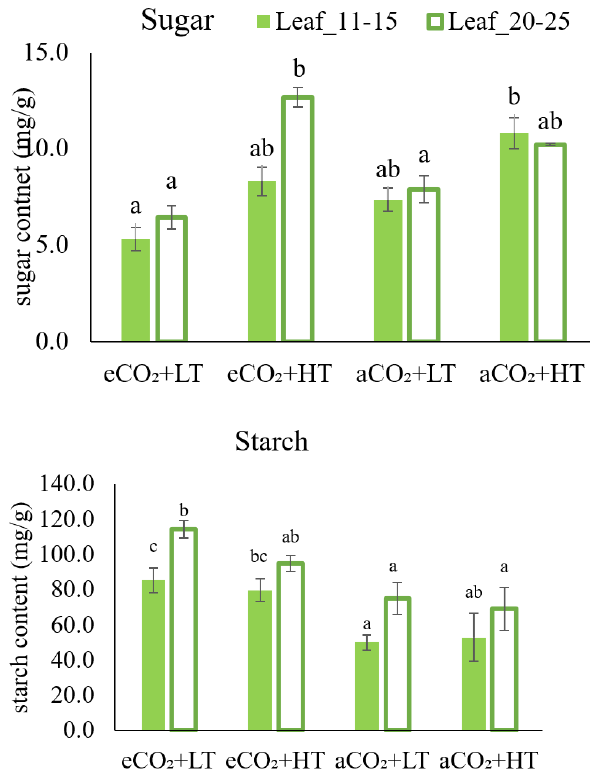
Figure 7. Soluble sugar and starch content in developing (numbers: 11–15) and developed (numbers: 20–25) leaves of plants under aCO 2 + LT, aCO 2 + HT, eCO 2 + LT, and eCO 2 + HT treatments. Error bars indicate SE of mean ( n = 3). Different lowercase letters indicate significant differences among treatments ( p < 0.005).